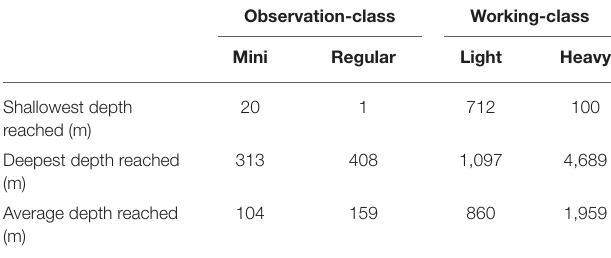
TABLE 2 | The shallowest, deepest, and average maximum depth (m) achieved by different classes of ROV systems to visually survey fish assemblages. Observation-class Working-class